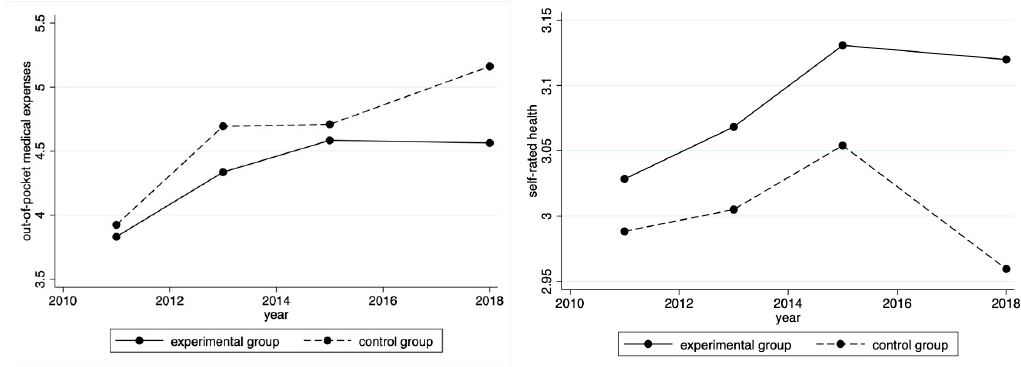
Figure 3. Time trends of out-of-pocket medical expenses ( left ) and self-rated health ( right ) in the experimental group and control group.